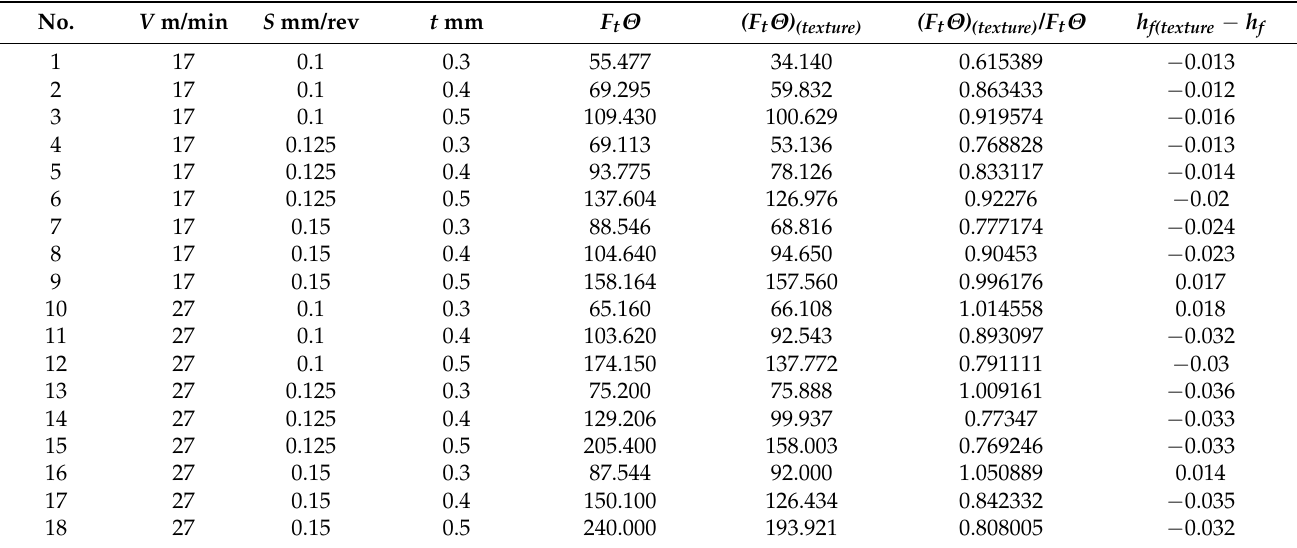
Table 9. Results of calculating the values of the relative efficiency